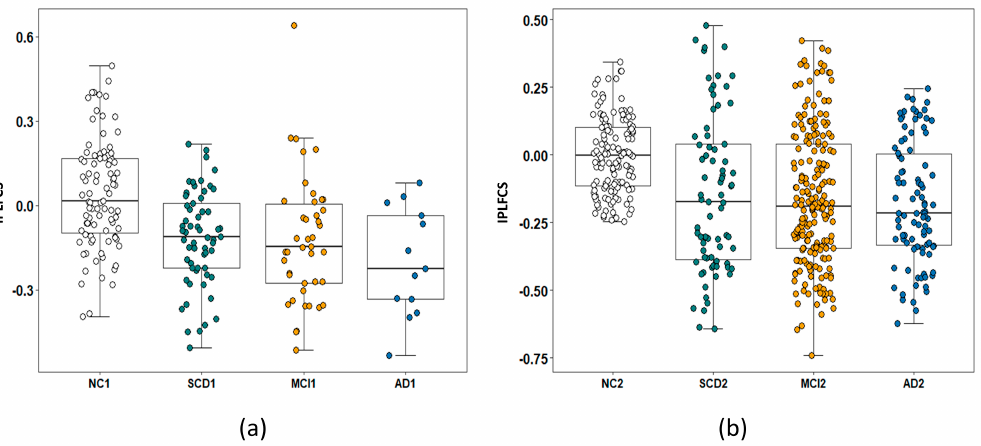
Figure 3. The IPLFCS in AD continuum. ( a ) The IPLFCS of LMTG in groups of cohort 1. ( b ) The IPLFCS of LMTG in groups of cohort 2.